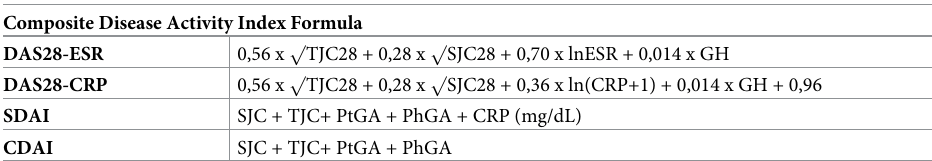
one index simultaneously. Residual activity was characterized by the proportion of patients Table 2. Composite disease activity indices formulas.